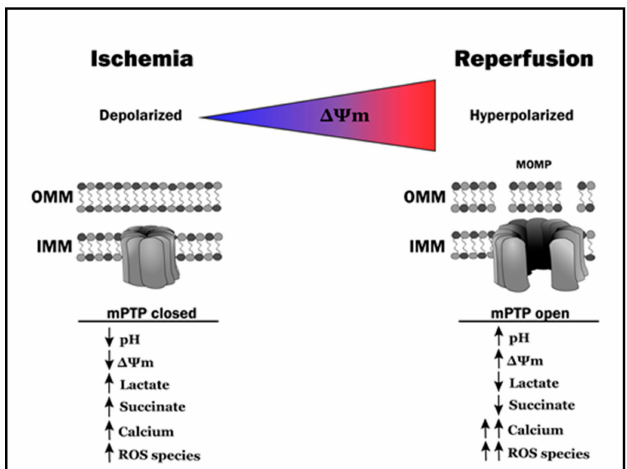
Figure 2. Cellular consequences of ischemia-reperfusion in cardiomyocytes. Under conditions of ischemia (left), mitochondria are depolarized (i.e., ∆Ψ m is decreased) and ATP stores are depleted. This is accompanied by acidosis secondary to lactate accumulation, and an increase in intracellular calciumconcentration. However, theOMMremainsintactandthemPTPremainsclosed. Reintroduction of oxygen (right), results in the raid normalization of pH and increase in ∆Ψ m, and precipitates multiple deleterious sequelae including generation of ROS, exacerbated calcium overload, disruption of the OMM and opening of the mPTP. OMM = outer mitochondrial membrane; IMM = inner mitochondrial membrane; MOMP = mitochondrial outer membrane permeabilization; mPTP = mitochondrial permeability transition pore; ∆Ψ m = mitochondrial membrane potential; ROS = reactive oxygen species. Adapted from reference